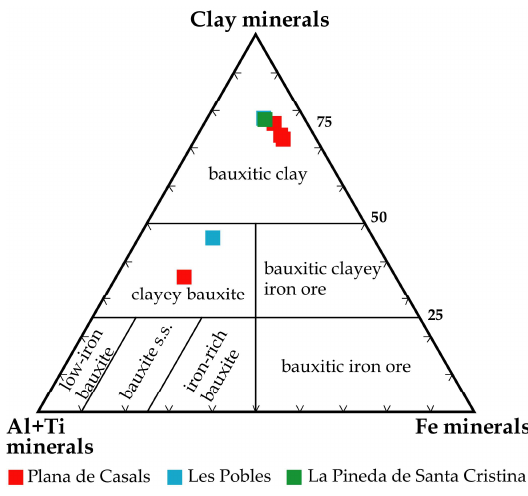
Figure 6. Ternary clay mineral-Fe mineral-Al+Ti mineral plot of the studied bauxitic samples based on results of semi-quantitative X-ray diffraction; bauxite classification fields after [22].